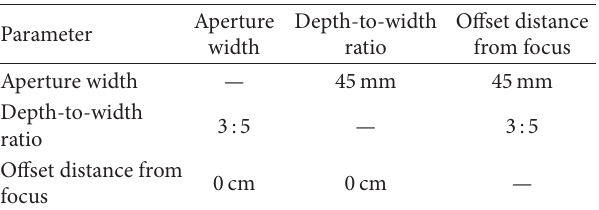
Table 1: Simulation parameters for the optical properties of the cavity absorber.